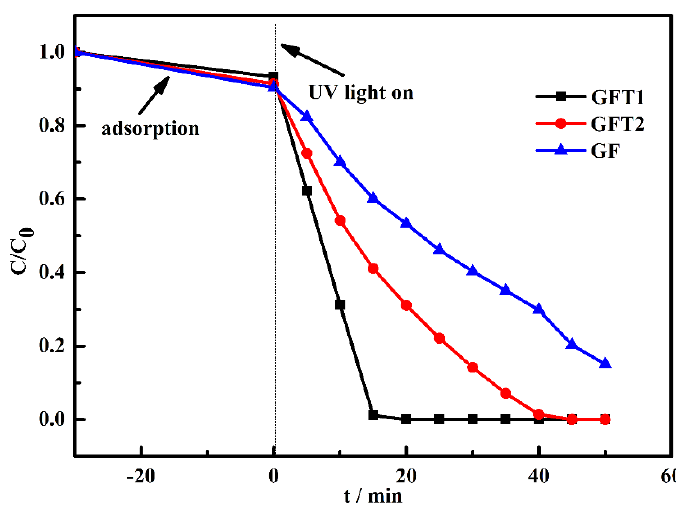
Figure 3. Change in MB concentration versus irradiation time of geopolymer and geopolymer-TiO 2 composites obtained by two preparation approach.